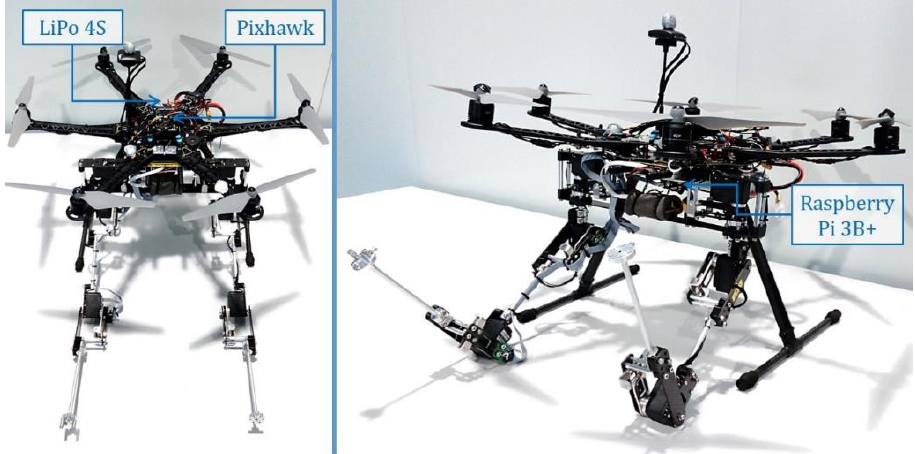
Figure 3 . Dual arm aerial manipulation robot.